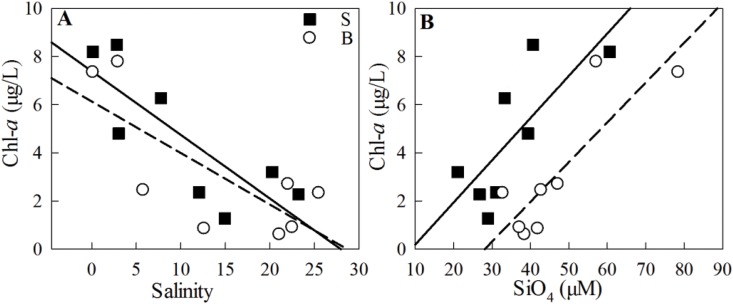
Relationship of salinity and chl-a (A), SiO4 and chl-a (B) during ST.In figure (A), the liner regression correlation coefficients (R2) were 0.66 (P < 0.01) and 0.56 (P < 0.05) at surface (solid line) and bottom (dash line), respectively. In figure (B), the correlation coefficients (R2) were 0.58 (P < 0.01) and 0.72 (P < 0.01) at surface and bottom, respectively.